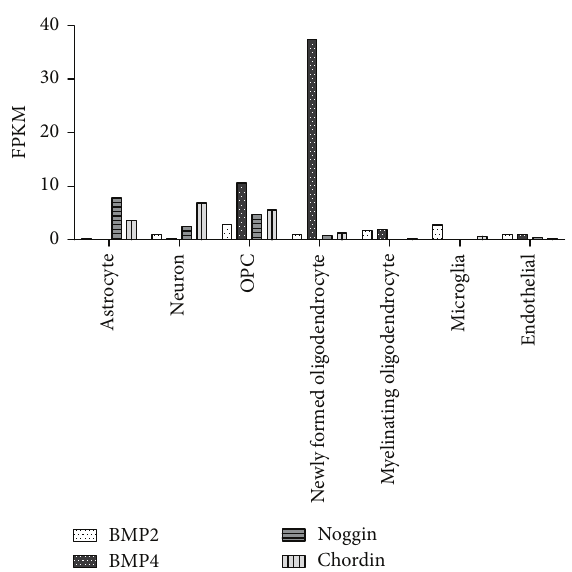
Figure 2: RNA-Seq transcriptome analysis showing increased transcription of Bmp4 transcripts in OPCs and newly formed oligodendrocytes in postnatal mice compared to other CNS cells. This is unique to Bmp4 ; closely related BMP2 does not show similar levels of increased transcription in oligodendroglial lineage cells compared to other CNS cells. Additionally, increased Bmp4 transcription does not appear to be counteracted by concomitant transcriptional increases expression of BMP inhibitors, such as noggin and chordin. The functional relevance of increased Bmp4 transcription by OPCs and immature oligodendrocytes remains to be clarified (FPKM = fragments per kilobase of transcript per million mapped